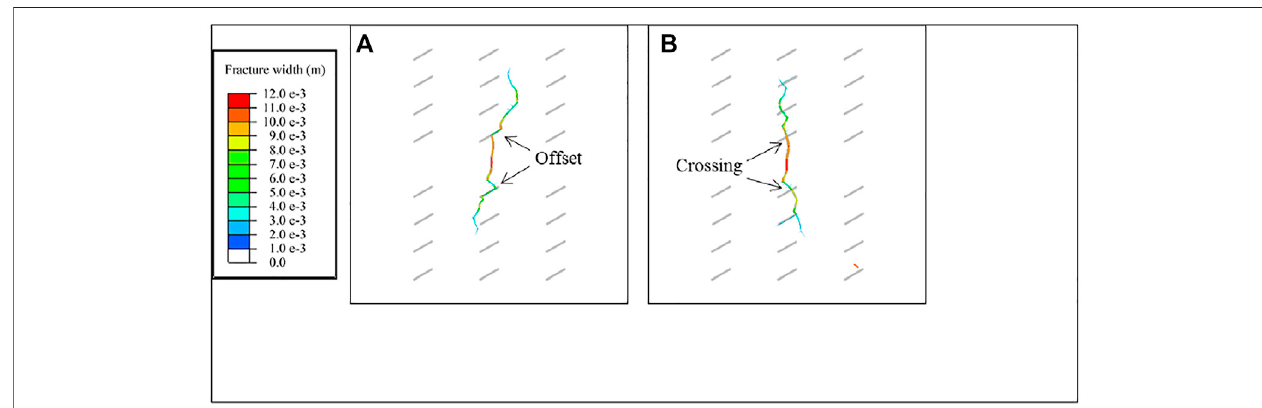
FIGURE 9 | Morphology of hydraulic fracture network under different fl uid viscosities: (A) case 1; (B) case 8.